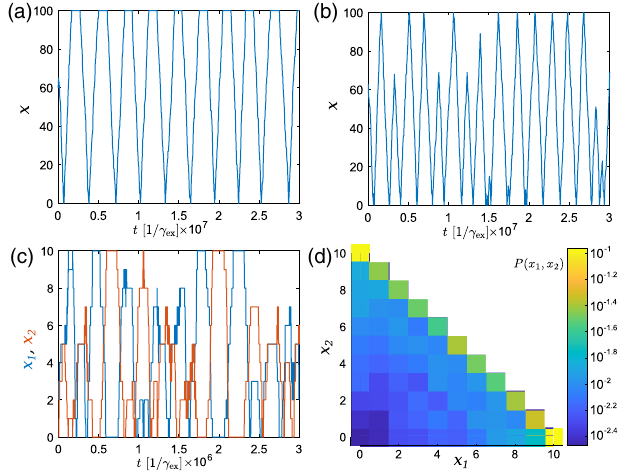
FIG. 8. (a) Simulated stochastic trajectory for the symmetric 10 − 4 γ three-state model with γ and size N x ¼ 100 . We in ¼ ex observe “ waiting times ” between growth and shrinkage. (b) When the upwards internal transition rate is increased to γ BA ¼ 10 − 2 γ ex , in making the system asymmetric, waiting times between growth and shrinkage become negligible, and it is more likely for the system to stochastically unbind from the edge state during growth, switching to shrinkage. (c) Trajectories for two systems, each described by the three-state model, coupled through the constraint x 1 þ x 2 ≤ N x describing competition for the same pool of monomers. Here, both systems have identical, symmetric 10 − 4 γ transition rates γ and size N x ¼ 10 . (d) Probability in ¼ ex distribution of finding a given x 1 and x 2 simultaneously, obtained from the same simulation, using a total of 10 7 steps starting from a random initial state. We find that symmetric systems clearly show antiphase synchronization; see also Movie 3 in the Supplemental Material